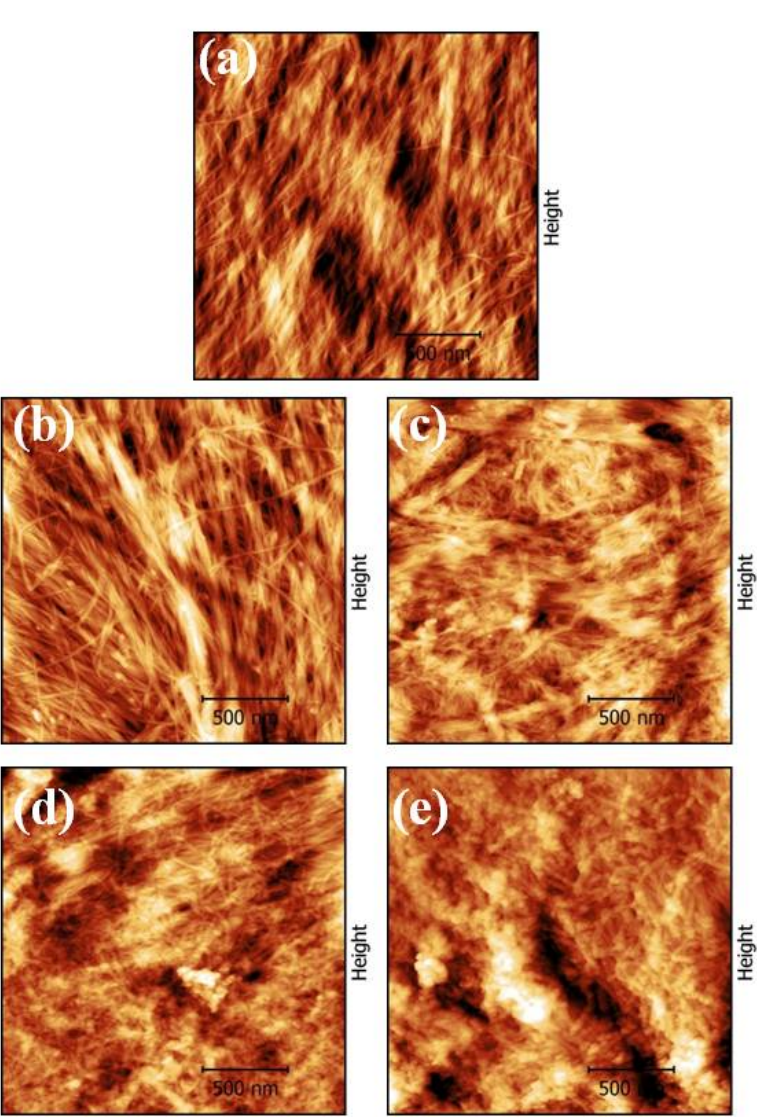
Figure 6. Atomic force microscopy (AFM) topography images of ( a ) blank paper sheet and ( b – e ) paper sheets modified with 0.125, 0.250, 0.500, and 1.0 % of TiO 2 , respectively.